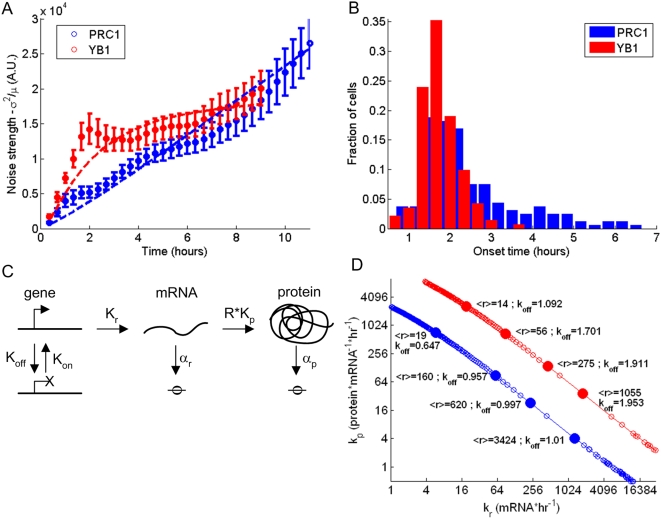
Variability of protein levels and accumulation onset times differs between PRC1 and YB1.(A) Noise strength (std2/mean) of PRC1 rises linearly (blue circles) and of YB1 saturates (red circles). Both 2-step and 3-step stochastic models reproduce these profiles of noise strength (blue solid line for PRC1 and red solid line for YB1). (B) Time interval between end of degradation to beginning of accumulation for PRC1 in blue and YB1 in red. The time of accumulation has an exponential tail (decay rate of 0.68±0.24 hr−1 for PRC1 and of 1.88±0.44 hr−1 for YB1). (C) Schematic of three stage model, with slow transitions between open and closed DNA. (D) Parameter estimation based on the slow switching model. As explained in the text, several parameters are estimated directly from the data, for PRC1; kon = 0.68±0.24, αr = 0 and αp = 0. For YB1; kon = 1.88±0.44, αr = 0.77±0.2 and αp = 0. For the rest of the parameters, the model was fit to data (mean and noise strength) and kp and kr were determined for a range of koff. Red and blue circles denote YB1 and PRC1 respectively. Values of average mRNA levels over the cell cycle and koff are shown for several parameters sets (filled circles).